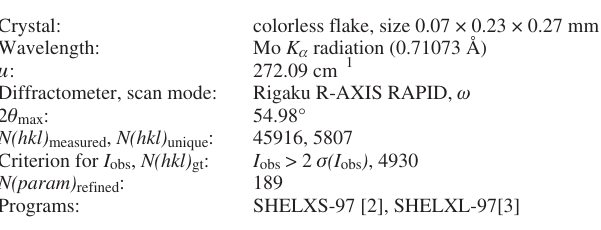
Table 1. Data collection and handling.